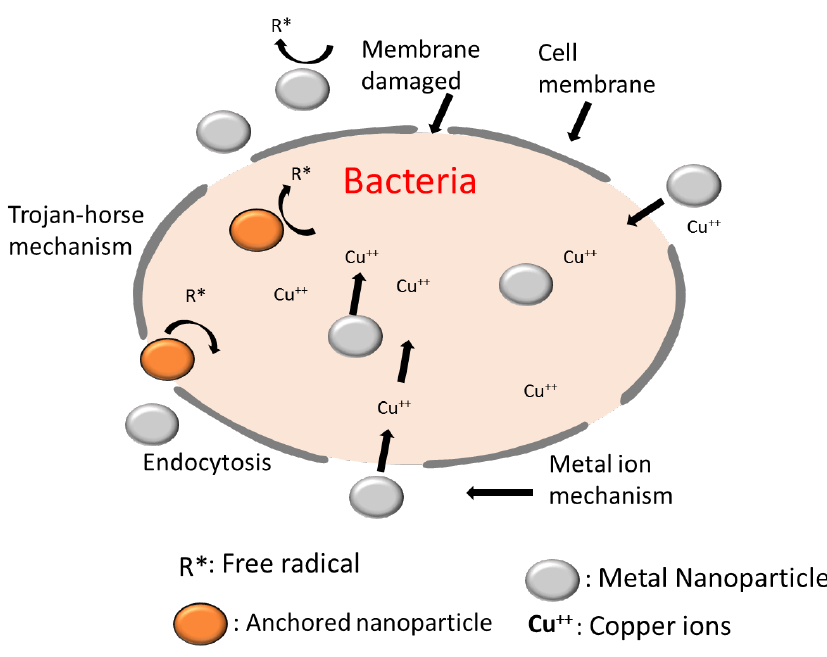
Figure 13. A simple overview of the mechanisms involved in the antimicrobial actions of metal nanoparticles, including catalyzed reactive species, metal ion discharge, and the “Trojan horse effect” caused by endocytosis mechanisms [21].